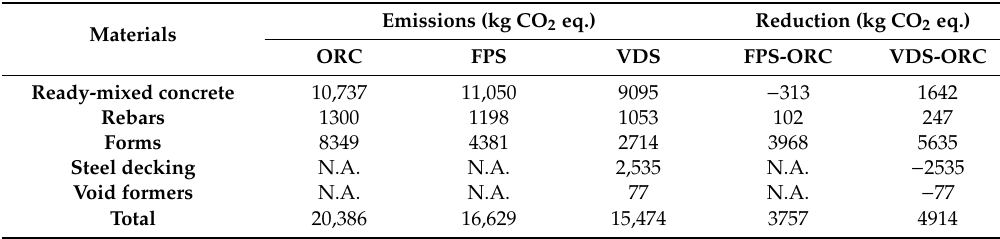
Table 10. Emissions of carbon dioxide from the construction equipment